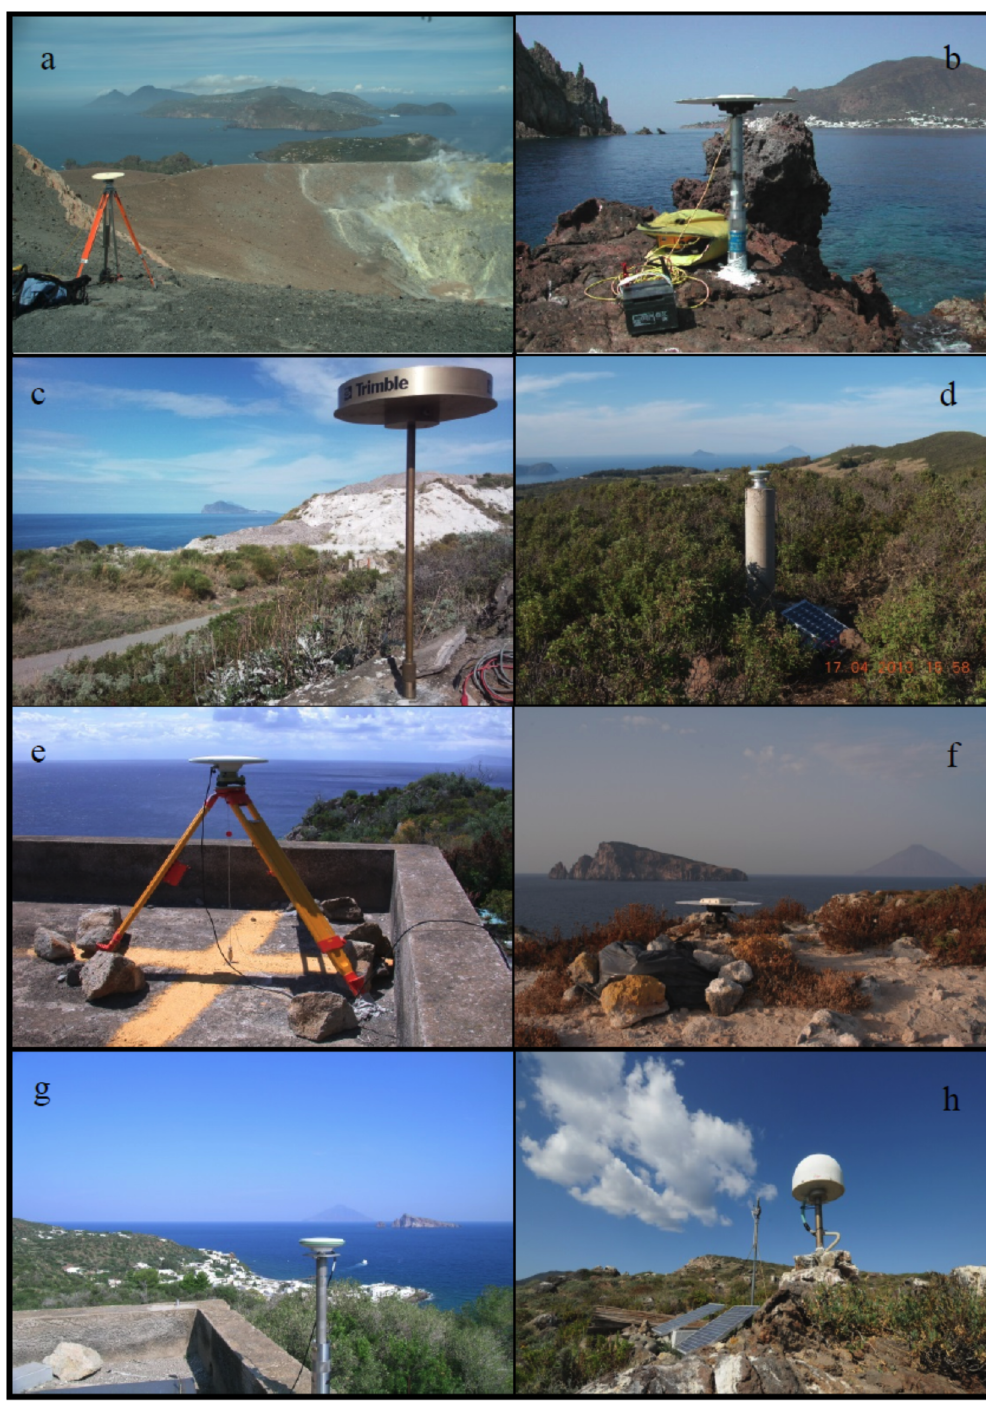
Figure 2. Typology of the GPS benchmarks: (a) iron spike fixed in rock outcrop, requiring tripod for antenna set up; (b) 3D iron made benchmark fixed in rocky outcrop. Antenna set up is constrained by the 3D monument (INGV type, Anzidei and Esposito [2003]); (c) Hun- garian type bronze made pole installed on benchmark fixed in rocky outcrop. Antenna set up is 3D constrained (used by INGV Catania and the former International Institute of Volcanology); (d) pillar built on rocky outcrop, with thread on top; (e) iron spike fixed on stable build- ing; (f) IGM marker fixed in rocky outcrop, with IGM base; (g) 3D benchmark on roof of stable building; (h) CGPS station (Lisca Bianca with 3D monument fixed on rocky